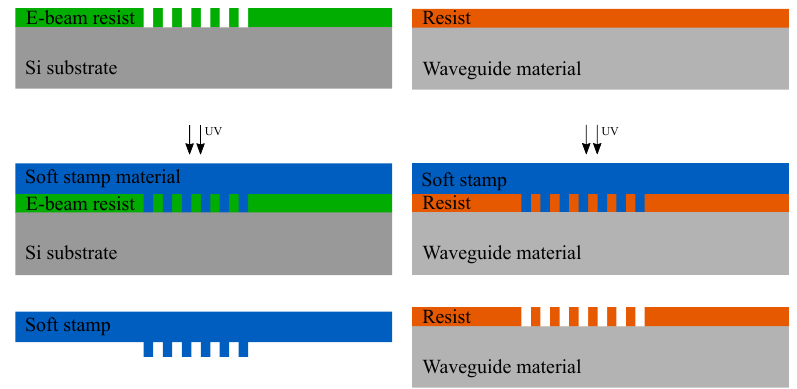
Figure 13. Schematic overview of the two-step imprint